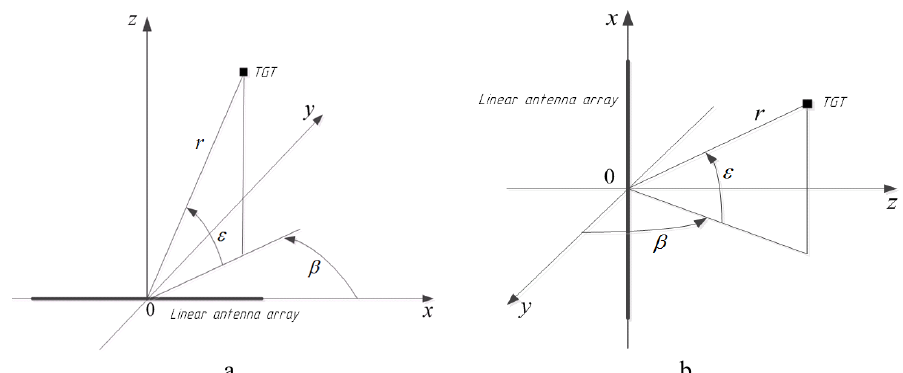
Fig. 2. Two variants of coordinate systems for generalized ambiguity function analyzing of MIMO antenna system. Coordinate system of type (I) is shown in (a), coordinate system of type (I) is shown in